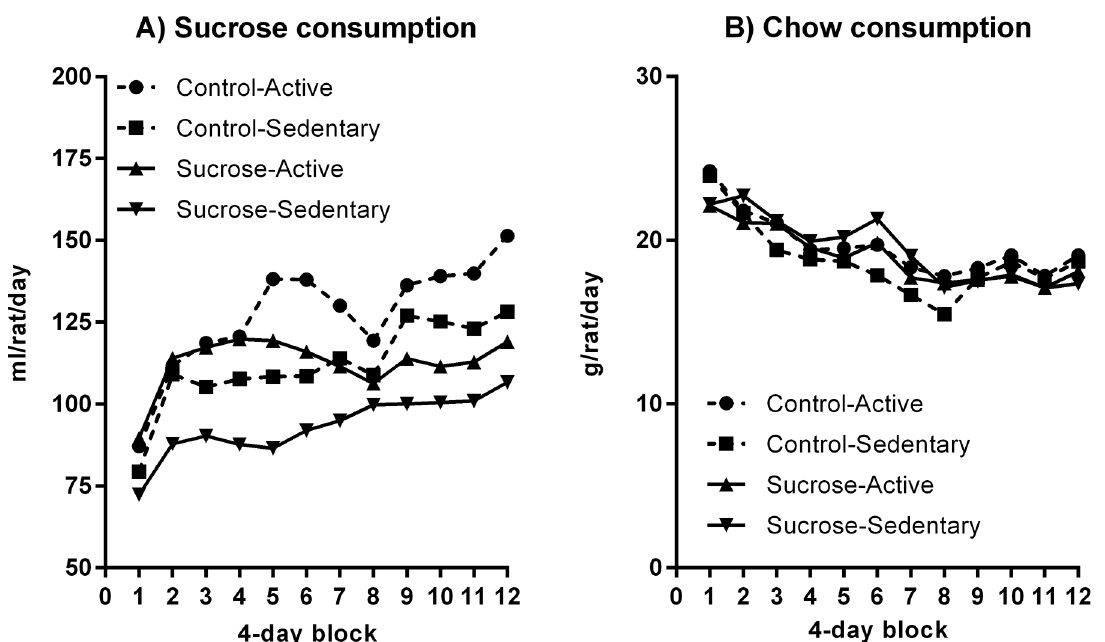
Fig 6. Wheel running in Stage 3. Wheel running (turns per 2-h session) did not differ between offspring of control and sucrose-fed mothers, and did not significantly change over the course of the